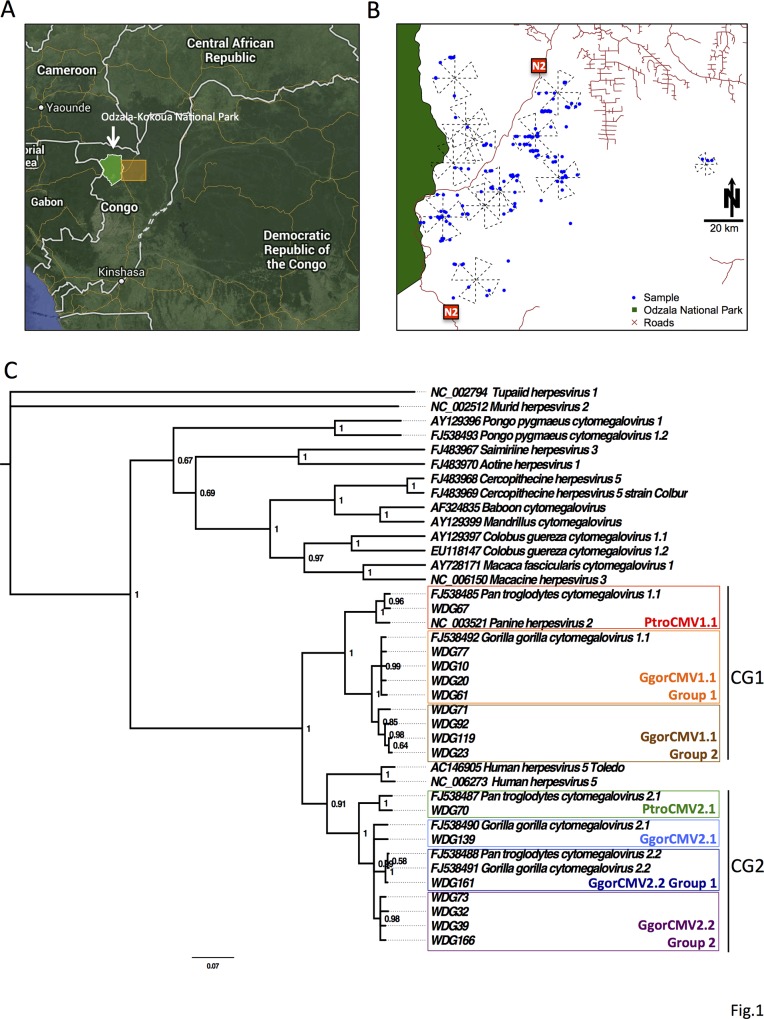
Location of sites and phylogenetic tree of herpesvirus lineages found in gorillas and chimpanzees.A. Map of the Republic of Congo showing the location of Odzala-Kokoua National Park (arrow) and the study area (yellow box). B. Shows the 12 sites where the samples were collected. Blue dots show where each sample was collected and the crosses show the extent of the survey sites. C. Phylogenetic tree of betaherpesviruses found in gorillas and chimpanzees. The tree was constructed through a nucleotide alignment of the herpesvirus CMV glycoprotein B gene using Bayesian analysis. Sample identification (WDG number) and Genbank accession numbers are shown. Bayesian posterior probabilities of branching demonstrate the robustness of the individual groups. Tupaiid herpesvirus 1 was used as the outgroup.